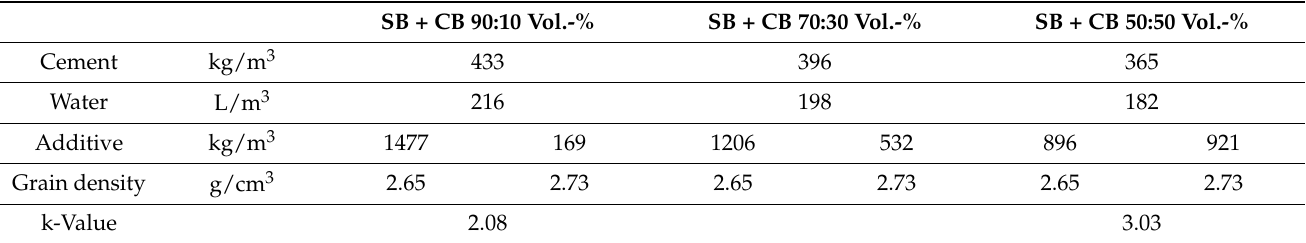
Table 2. Formulations for concrete of strength class C 25/30 with secondary m-sand substitutes: broken brick material.